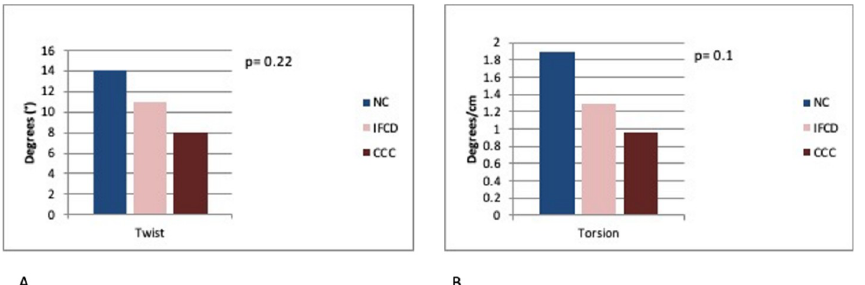
Fig 3. LV Twist (panel A) and torsion (panel B) between groups. Fig 3 depicts median values of twist (panel A) and torsion (panel B) with a tendency of reduction from NC to IFCD and to CCC. p-value of comparison between NC vs IFCD.